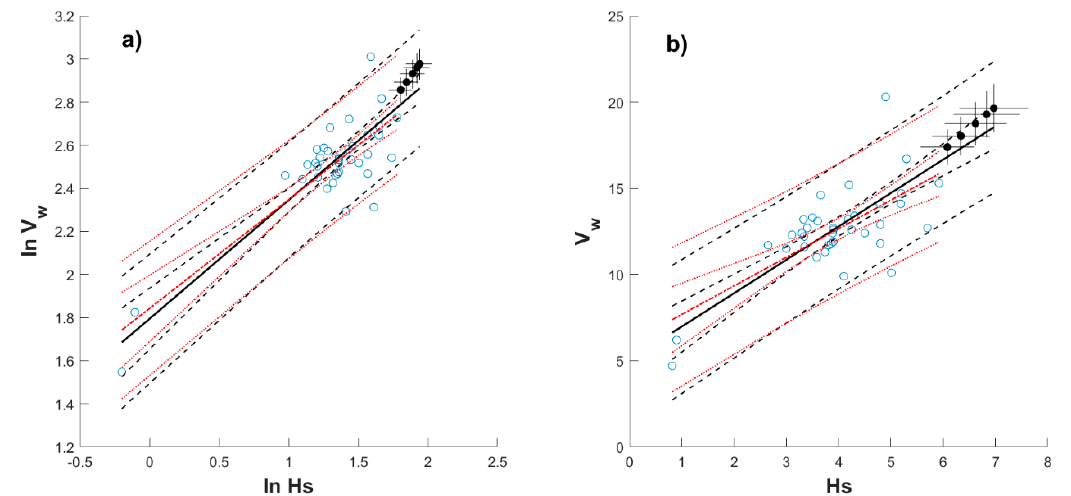
Figure A1. Regression lines and confidence intervals including (solid and dashed lines, respectively) and excluding (dashed–dotted and dotted lines, respectively) T -yr values for January; ( a ) and ( b ) for logarithmic space and linear space, respectively. Filled circles represent T -yr values with embedded perpendicular lines indicating confidence intervals from GEV models.